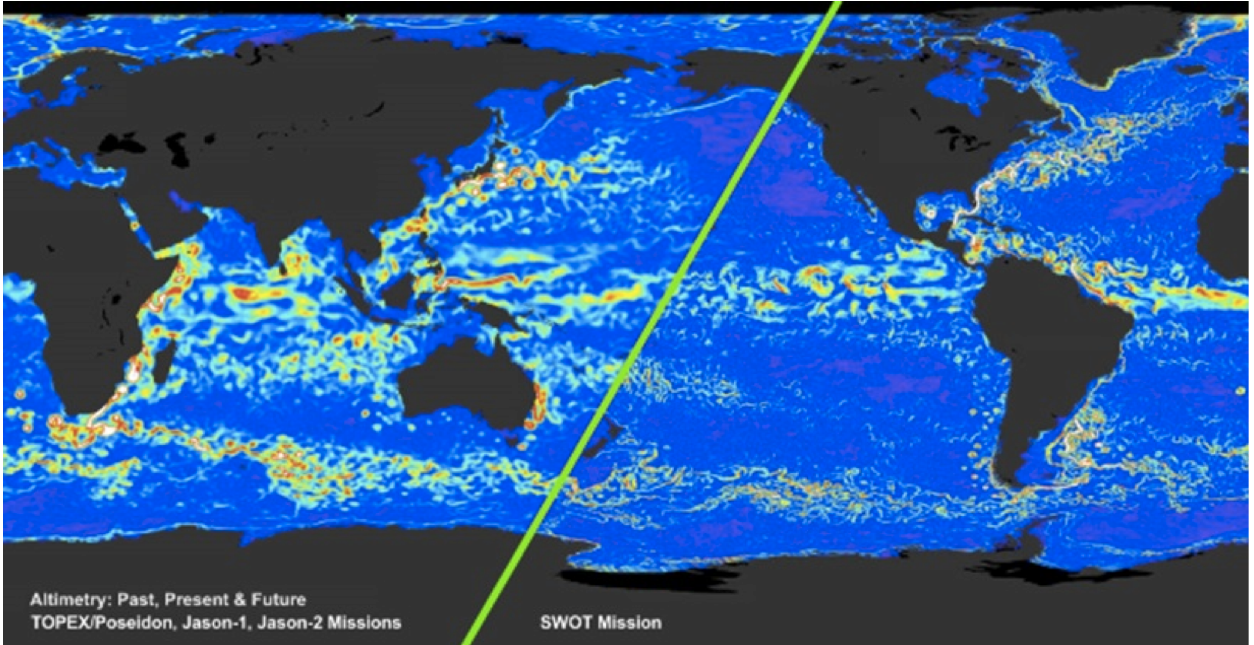
Figure 3. Comparison of data resolution from simulated past and current altimetry missions on the left side of the graphic and expected SWOT data resolution on the right. Credit: